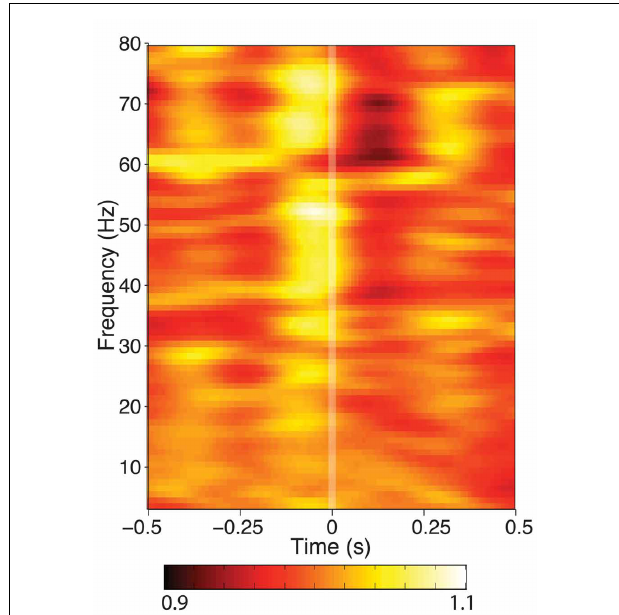
FIGURE 3 | Time-frequency spectrogram of hippocampal activity aligned to fixation onset during visual search, grand averaged across each patient. Frequency was measured from 3 to 80Hz at 1Hz intervals, time was measured in 800ms Hanning-tapered windows, shifted every 10ms. For visualization of each frequency band, power is presented in each band relative to the average seen for that frequency band between ± 800ms around fixation onset. None of the hippocampal recording sites showed theta power modulation, though some exhibited modulation in higher frequency bands.